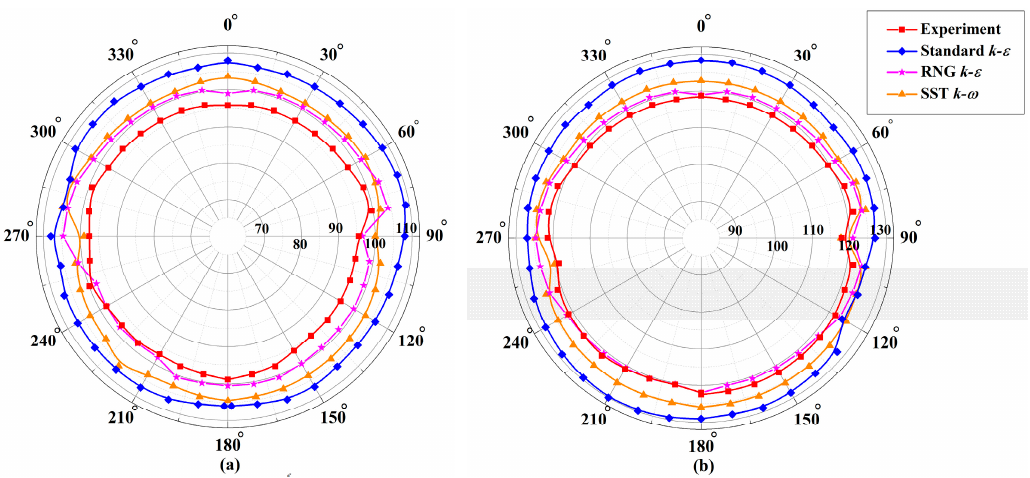
Figure 17. Directional distribution of the radiated noise at ( a ) BPF 1 and ( b ) BPF 2.